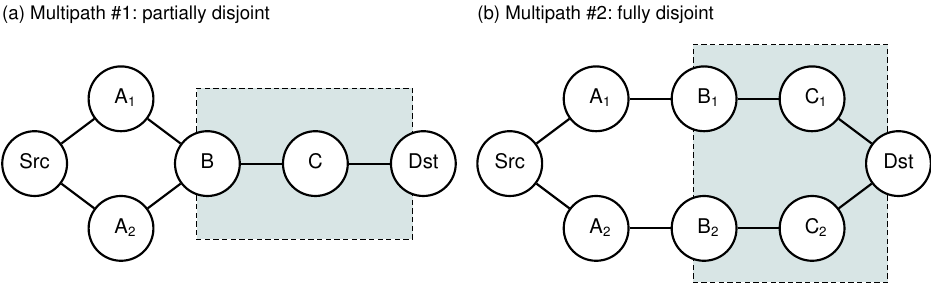
Figure 1. Source AS Src has two links to next hop ASes A 1 or A 2 but ( a ) shows partially disjoint paths that the multi-paths between Src and Dst uses same links from AS B to AS Dst , which can be disconnected by a single link failure, whereas ( b ) shows fully disjoint paths that cannot be disconnected by a single link